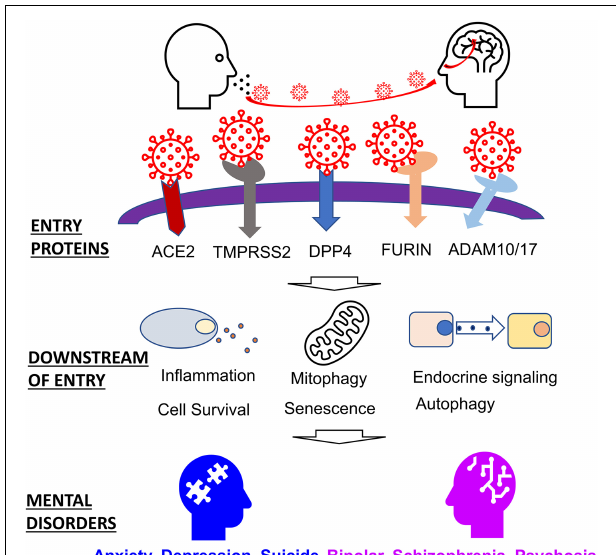
FIGURE 1 | Host factors involved in SARS-CoV-2 entry and related mental